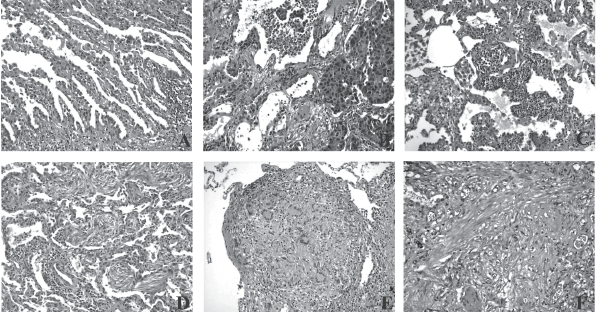
Figure 3 - A (HE, 200X): pneumocytes hyperplasia; B (HE, 200X): neoplastic parenchymal infiltration; C (HE, 200X): mononuclear cell interstitial infiltrate; D (HE, 200X): granulation tissue filling alveolar spaces; E (HE, 200X): granuloma; F (HE, 200X): fibrosis (fibrocellular